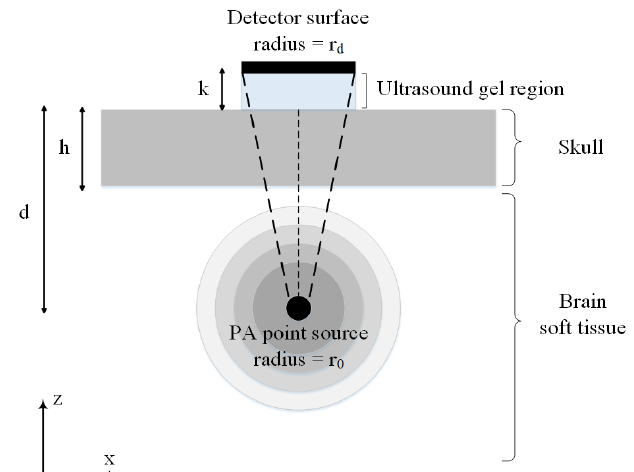
Figure 2. 2-D illustration of a simple model of skull used in our simulations. The model consists of a skull bone with a thickness of h located above the brain tissue. The spherical PA imaging target with the radius of r 0 is located at a depth of d below the skull layer and a flat ultrasound transducer with an element diameter of 2 r d is remained in contact with the outer-skull surface and the coupling